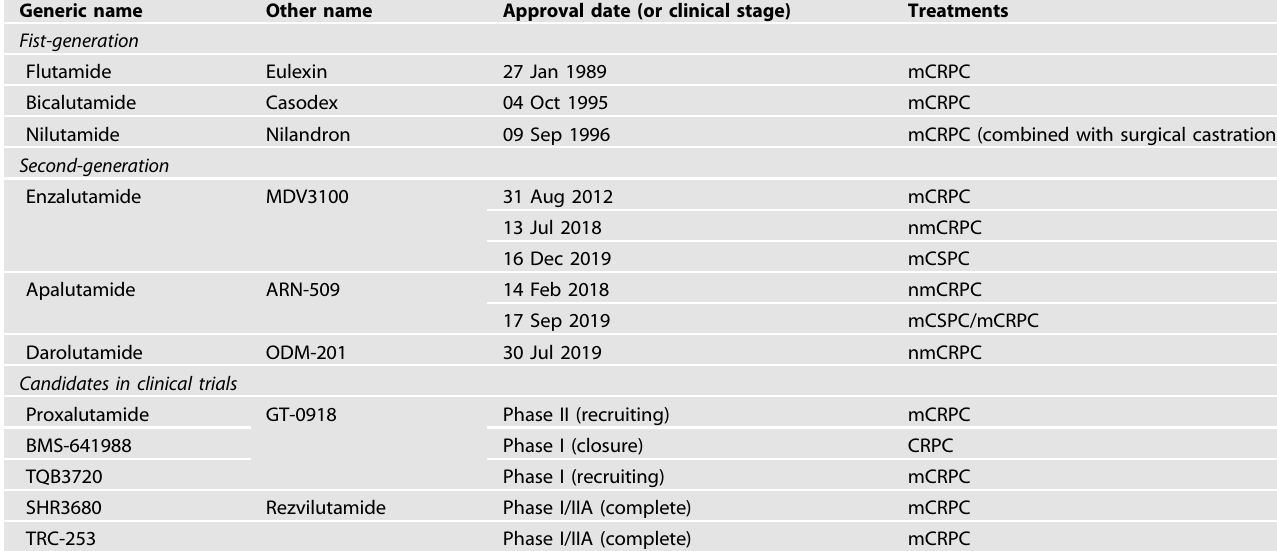
Table 1. Timeline for the development of AR antagonists for prostate cancer.